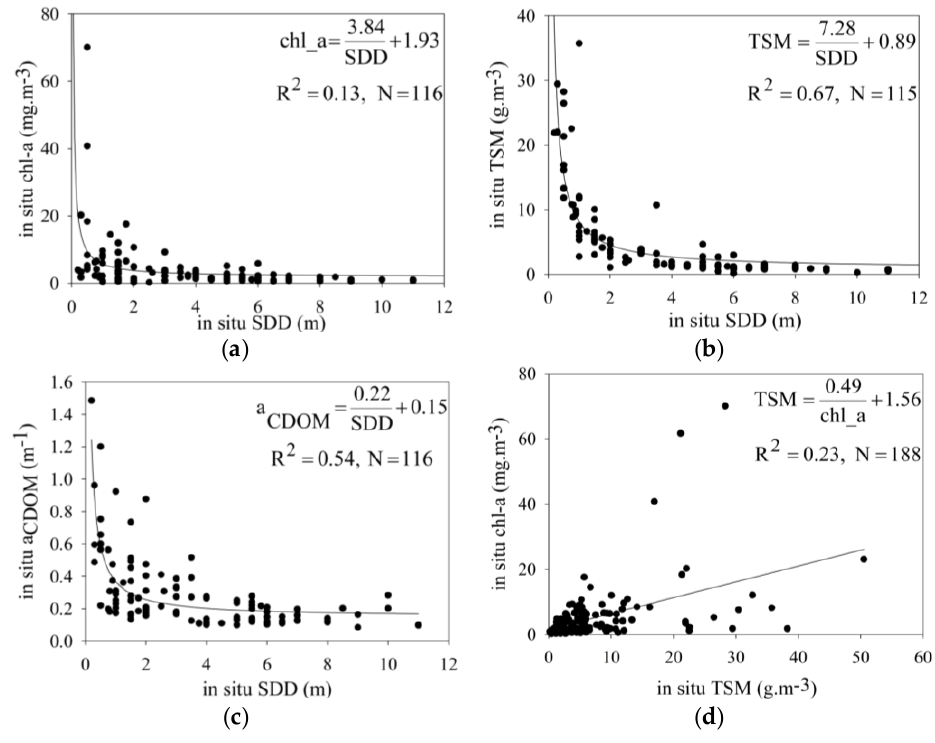
Figure 2. Relationships between in situ SDD and three bio-optical parameters of the water: chl-a ( a ); TSM ( b ); and a CDOM (440) ( c ); Relationship between in situ chl-a and in situ TSM is also shown ( d ).